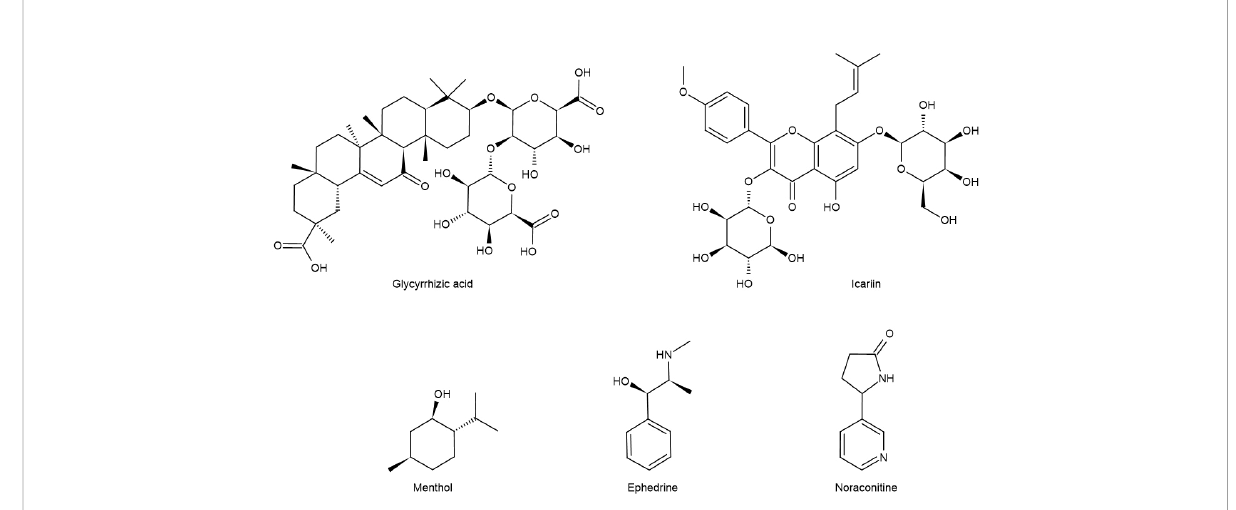
FIGURE 3 Chemical formula of some monomers of traditional Chinese medicine for the treatment of